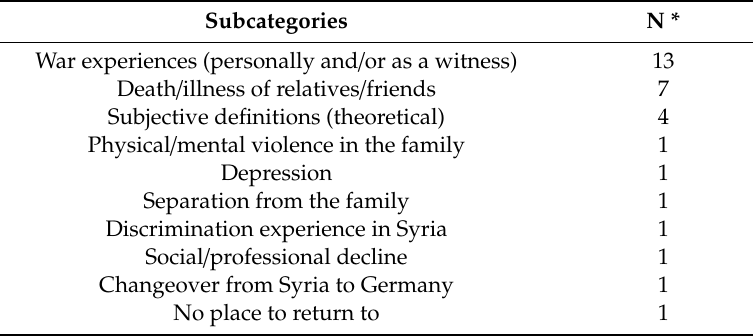
Table 2. Events described as